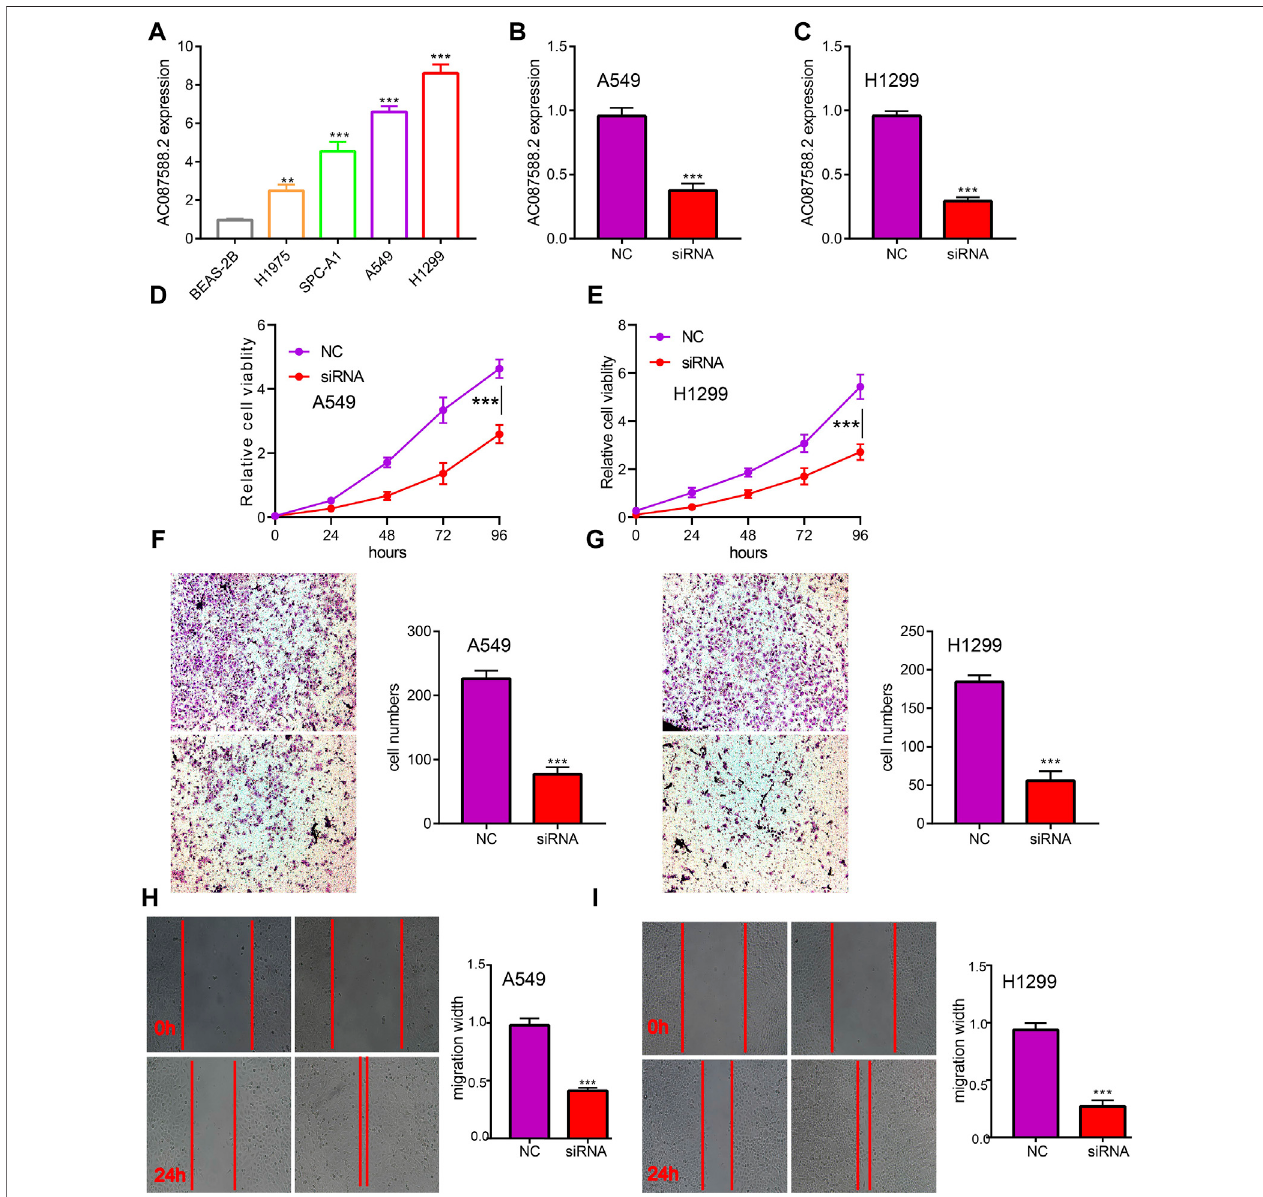
FIGURE2 | AC087588.2modulates LUAD cell proliferation and migration in vitro . (A) Theexpression of AC087588.2 inLUAD cell lines examined by qPCR. (B – C) qPCR assay examined the knockdown ef fi ciency of AC087588.2 in A549 and H1299 cells (D – I) AC087588.2 knockdown inhibited cell proliferation and migration examined by CCK8, transwell and wound healing assay. ** p < 0.01, and *** p < 0.001. NC = negative control, siRNA = AC087588.2 siRNA.